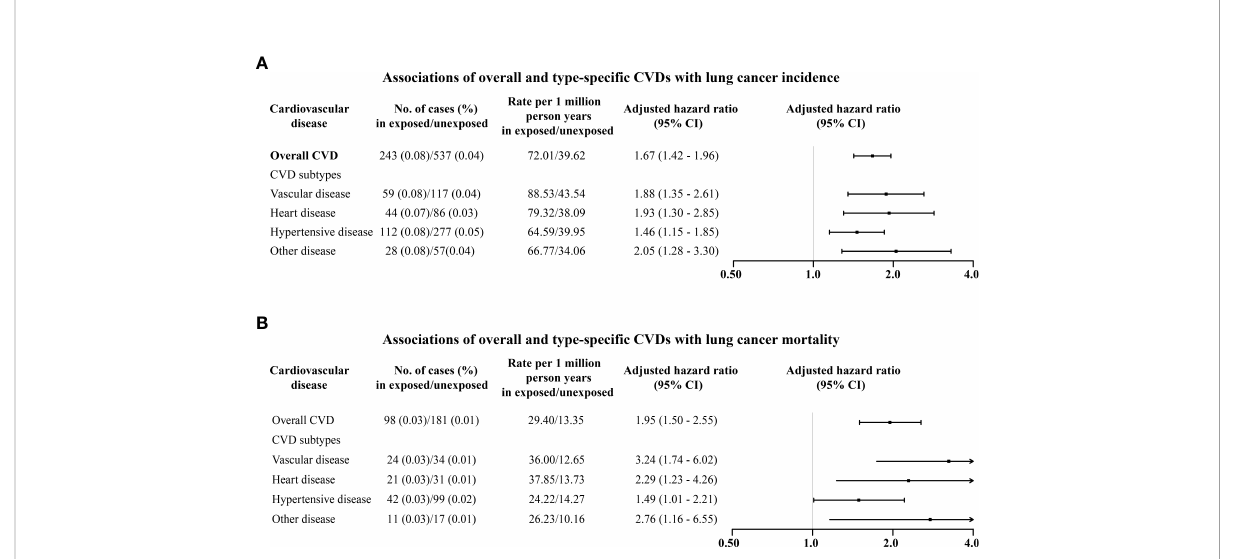
FIGURE 1 Associations of overall and type-speci fi c CVDs with lung cancer incidence (A) and lung cancer mortality (B) . Controlled for matching factors (age and sex) by design and adjusted for obesity, diabetes mellitus, smoking disorders, alcohol disorders, marital status, and educational